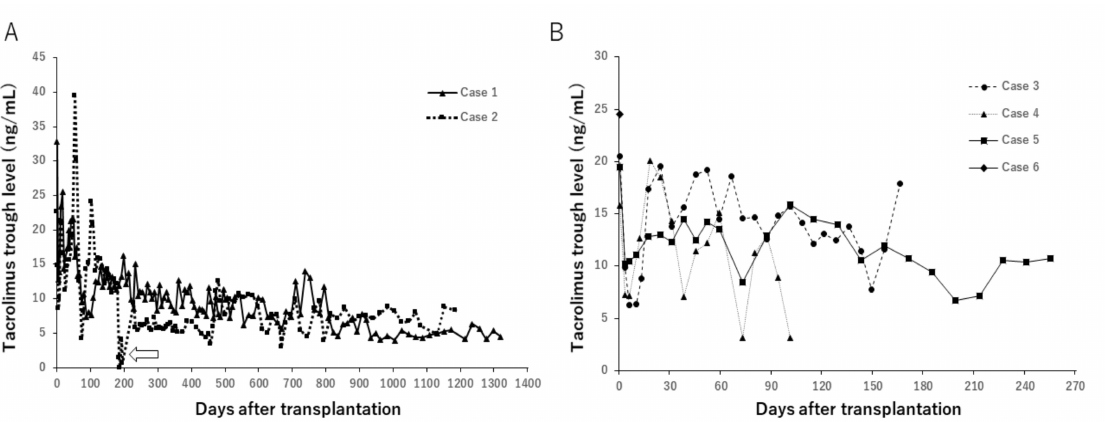
Figure 4. Change of trough levels of tacrolimus in case 1 and 2 ( A ) and case 3 to 6 ( B ). In case 2, TAC was withdrawn from POD 191 to 220 due to PTLD development, resulting in occasional low trough levels during the period